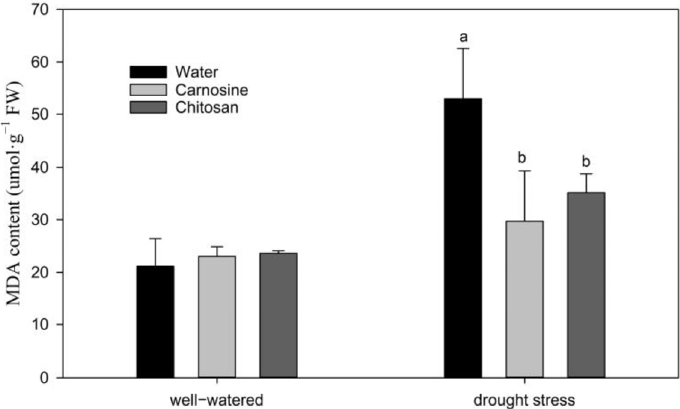
Figure 7. Effects of carnosine and chitosan on MDA content in bermudagrass. ‘Water’ represents control plants sprayed with distilled water under both well-watered and drought stress. The columns represent the means and standard errors (SE) of 5 replicates. Different letters represent a significant difference among treatments at the same time point at p < 0.05.